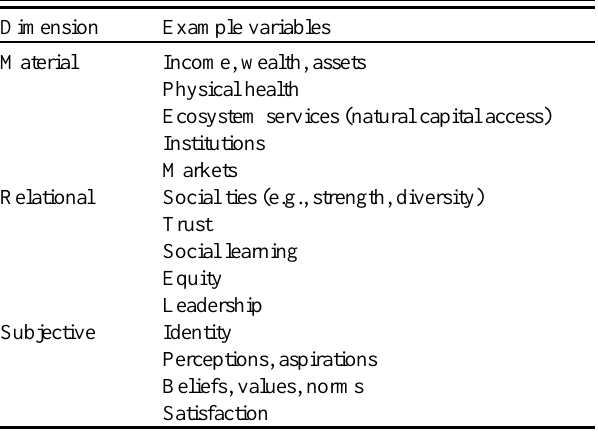
Table 3 . Examples of potential controlling social variables (fast,